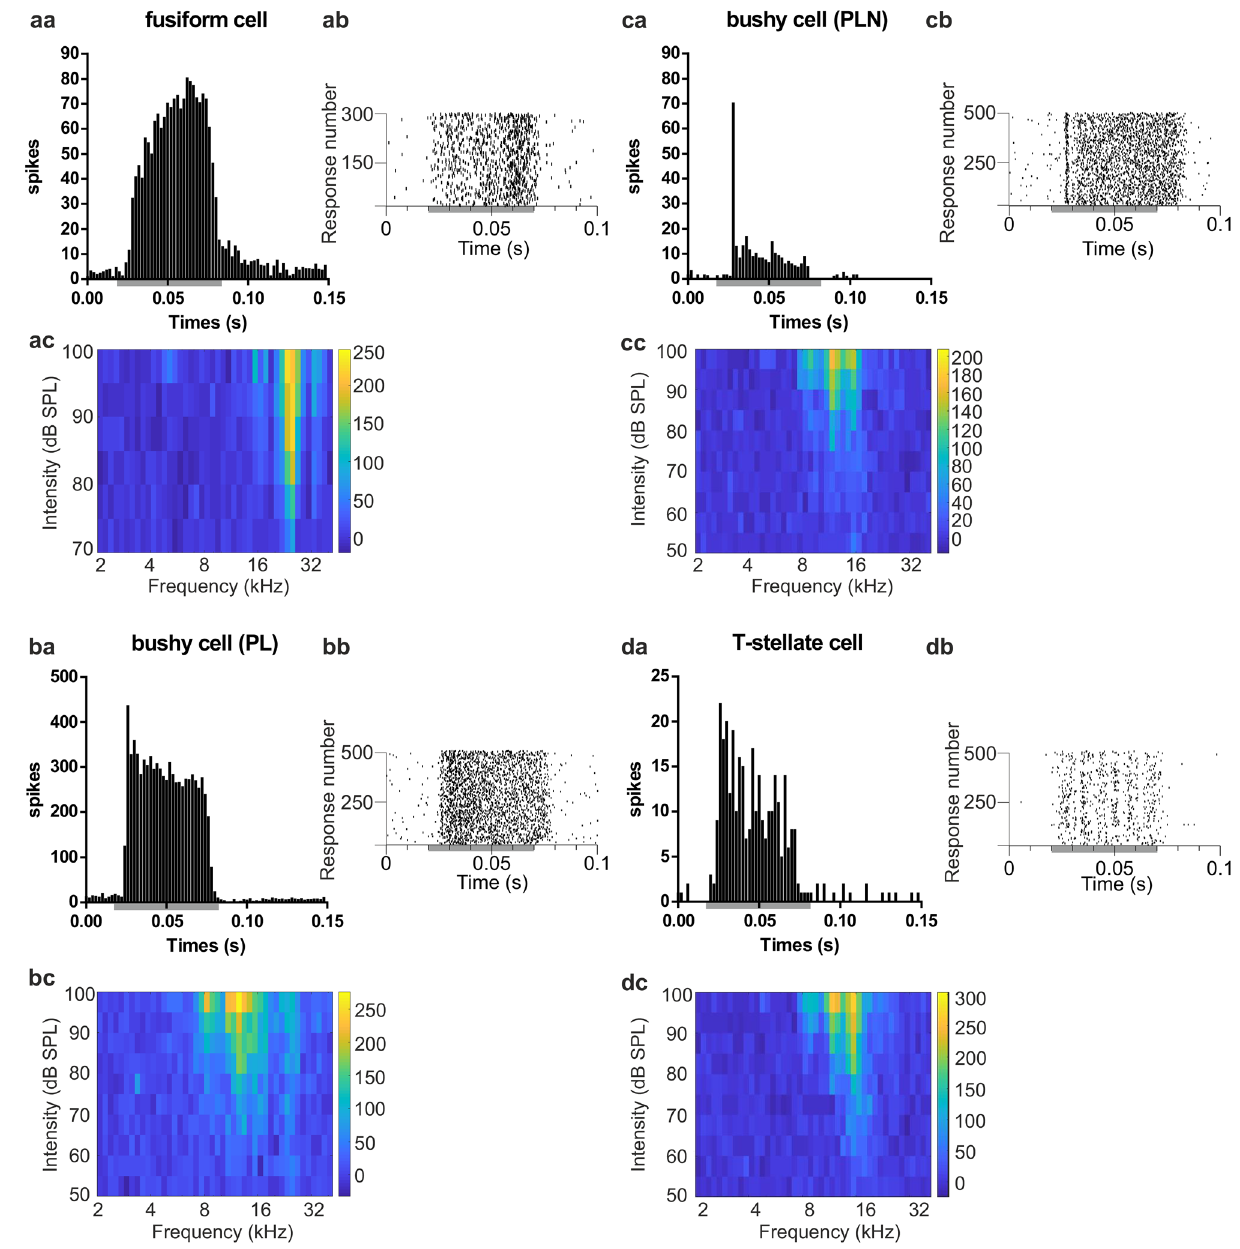
Figure 1. Cell classification. The neurons recorded in the cochlear nucleus were classified based on their characteristic response profile. ( aa ) Post-stimulus time histogram (PSTH, 2 ms bin, 300 sweeps) of a spike- sorted unit from a fusiform cell in DCN recorded during best-frequency tone stimulation (24,261 Hz) at 20 dB above threshold. The PSTH shows the characteristic build-up response. ( ab ) Raster plot of the fusiform cell from aa . ( ac ) Receptive field (frequency intensity response pattern; colour code is spike rate in 50 ms from 10 sweeps) for the same fusiform cell. ( ba ) PSTH (2 ms bin, 500 sweeps) of a spike-sorted unit from a primary-like bushy cell (PL) in VCN recorded during best-frequency tone stimulation (12,130 Hz). ( bb ) Raster plot of the primary- like bushy cell from ba . ( bc ) Receptive field (colour code is spike rate in 50 ms from 10 sweeps) for the primary- like bushy cell in ba . ( ca ) PSTH (2 ms bin, 500 sweeps) of a spike-sorted unit from a primary-like-with-notch bushy cell (PLN) in VCN, recorded during best-frequency tone stimulation (10,560 Hz). ( cb ) Raster plot of the PLN bushy cell from ca . ( cc ) Receptive field of the primary-like bushy cell with notch. ( da ) PSTH (2 ms bin, 500 sweeps) of a spike-sorted unit from a t-stellate cell in VCN, recorded during best-frequency tone stimulation (14,934 Hz). ( db ) Raster plot of the spike-sorted t-stellate cell from da . ( dc ) Receptive field (colour code is spike rate in 50 ms from 10 sweeps) for the t-stellate cell. In the panels showing PSTH and raster plots, the grey bar is the 50 ms tone